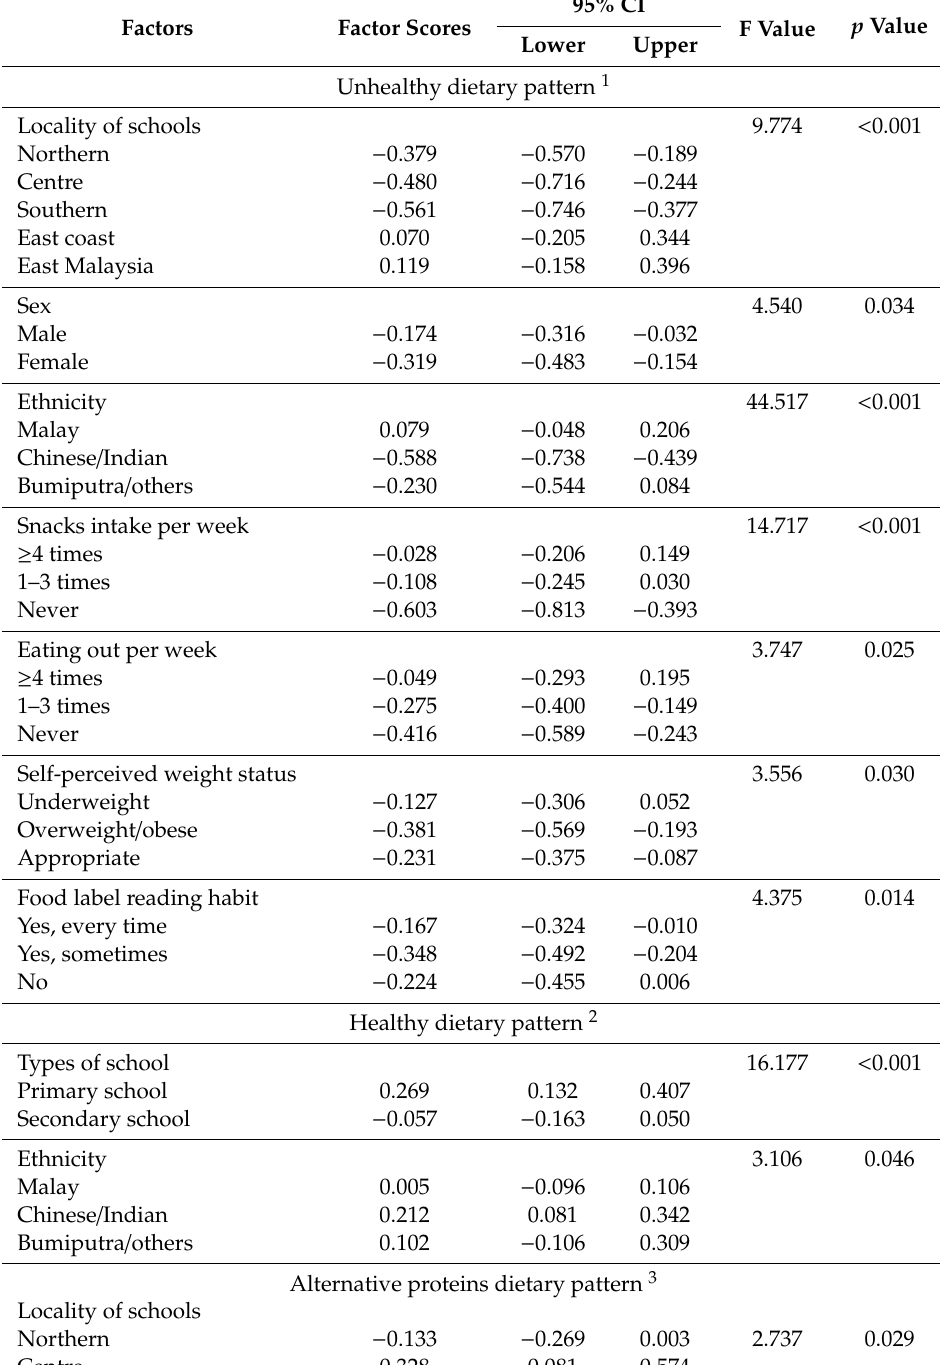
Table 5. Factors associated with dietary pattern among